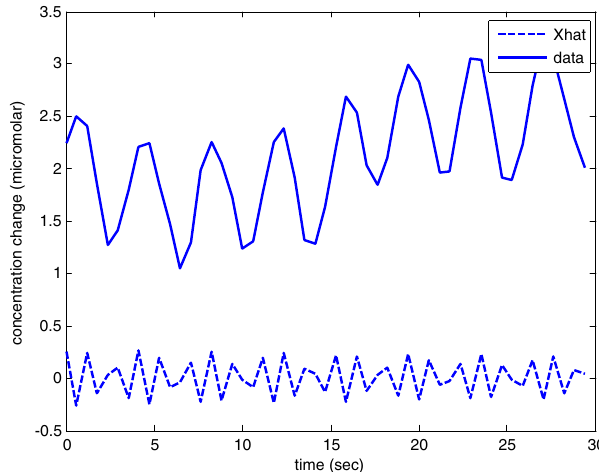
Fig. 6. Real contaminated signal (solid line) and denoised signal (dashed line) after using ARMA based method. Table 4. Results of applying ARMA based method to real data. Signal